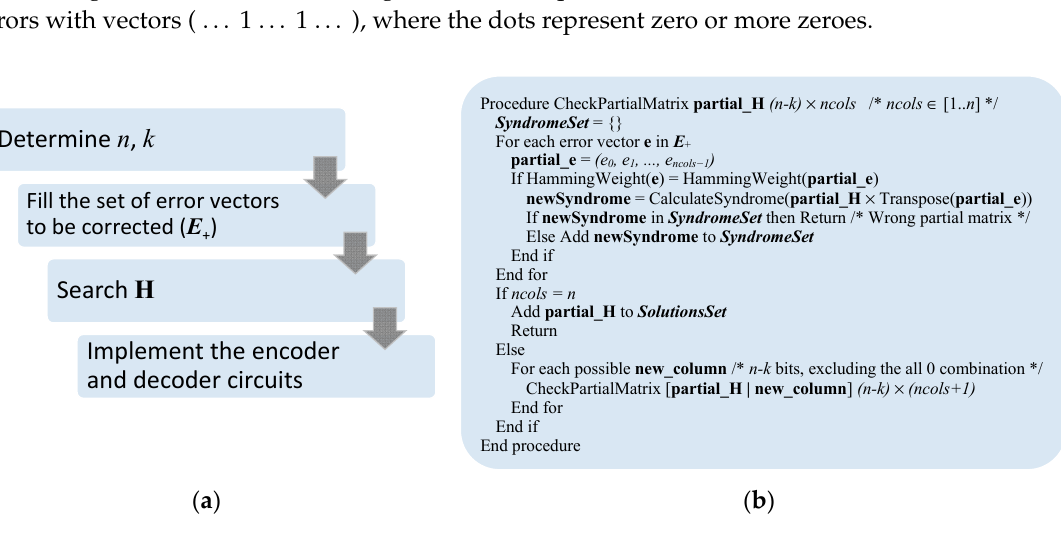
Figure 2. Searching parity check matrices methodology based on the set of error patterns to be corrected: ( a ) flow chart and ( b ) recursive backtracking algorithm (extracted from [19]).